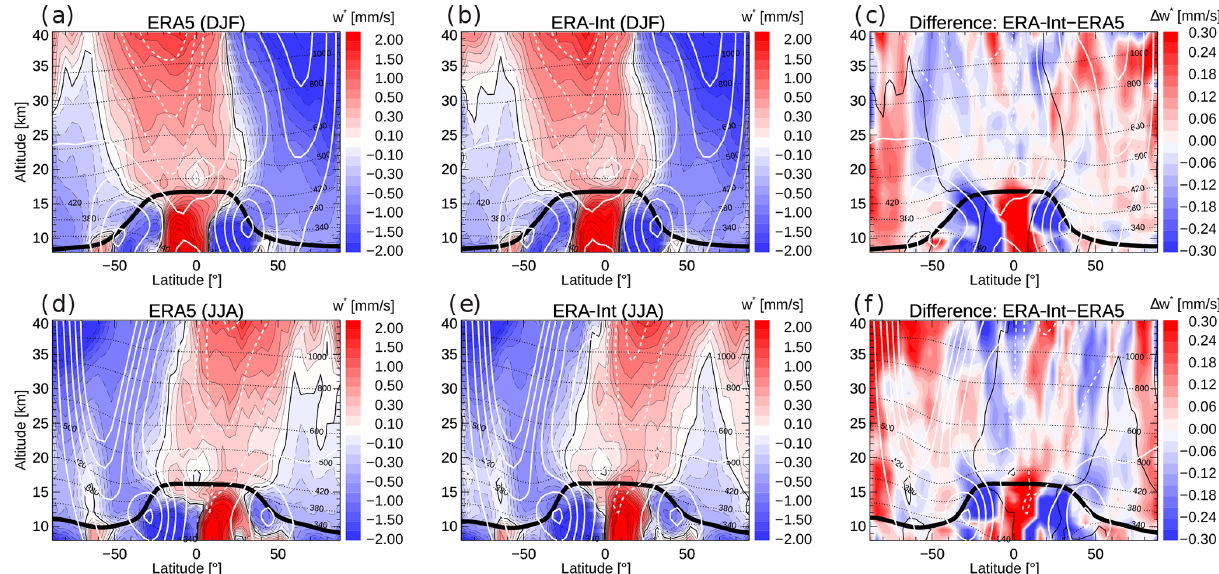
Figure 2. Residual circulation vertical velocity w ∗ climatology (1979–2018) for boreal winter (December–February, DJF) from (a) ERA5, (b) ERA-Interim, and (c) the difference ERA-Interim minus ERA5. Panels (d) – (f) are the same but for boreal summer (June–August, JJA). Note the different colour scale for the difference plots. Circulation contours are highlighted in black (dashed for negative values). White contours show zonal wind (in ± 10m/s steps; easterly wind dashed), the thin dashed black lines show potential temperature levels, and the thick black line shows the (WMO lapse rate) tropopause. The y axis is log-pressure altitude.